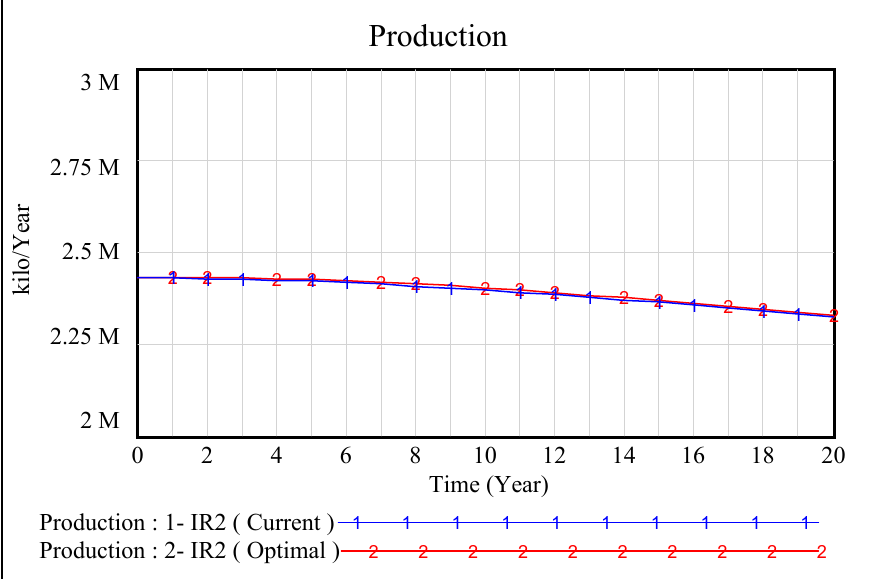
Figure 15. The comparison diagram of the effect of the current and optimal input rate 2 on milk production.